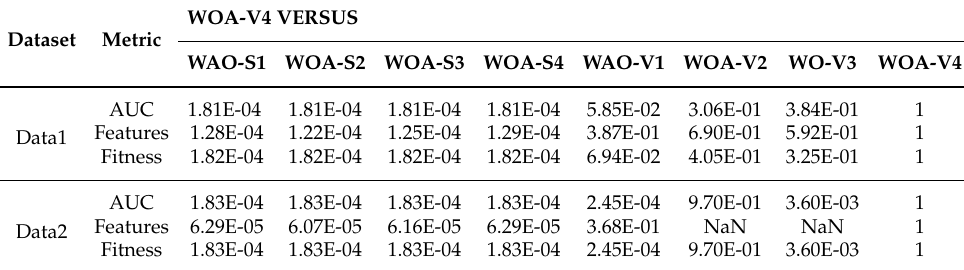
Table 11. p -values of the Wilcoxon test for the AUC, number of features, and fitness results of the top variant WOA-V4 versus other variants ( p ≤ 0.05 are presented in bold face, NaN: means Not